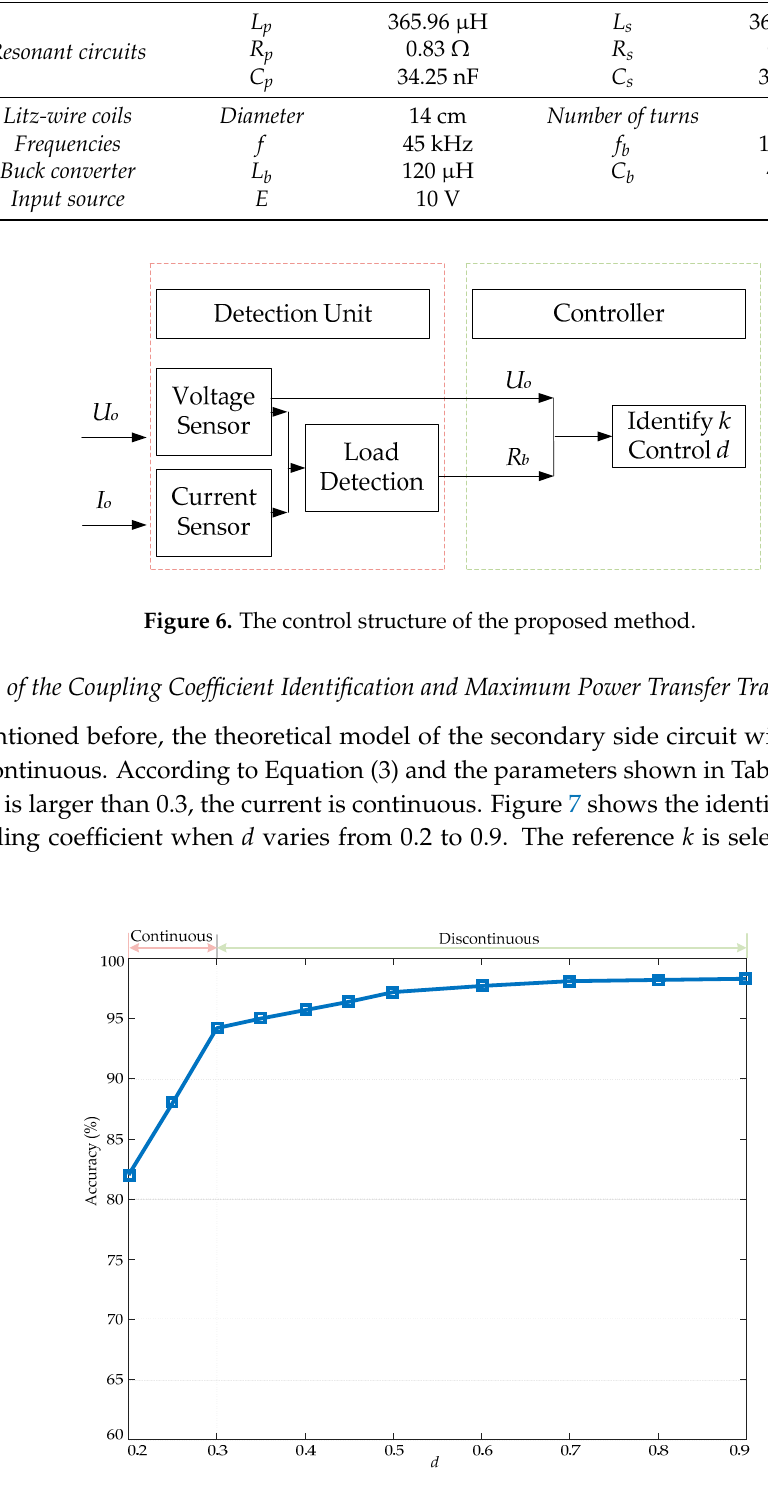
( b ) Figure 8. Maximum power tracking when load R b changes with different k : ( a ) k = 0.0811; ( b ) k = 0.0448.